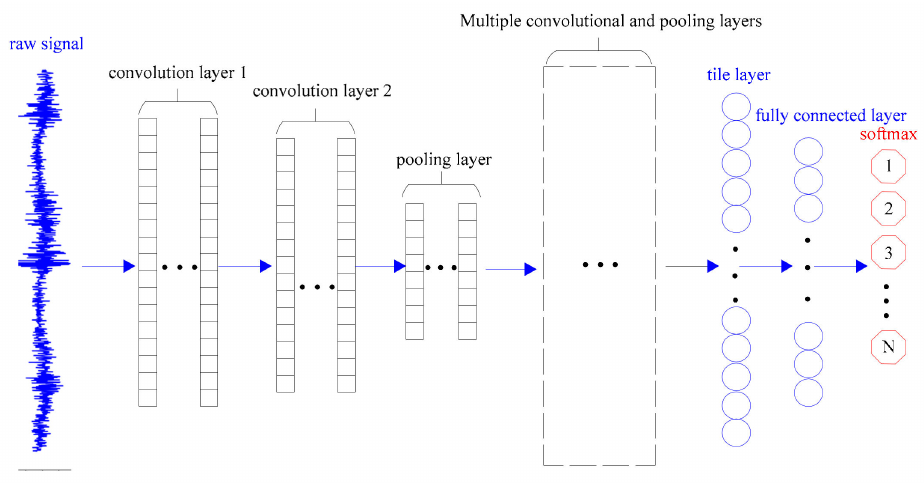
Figure 4. Schematic of a fault diagnosis model for a single measuring point reciprocating compressor in a 1D CNN.